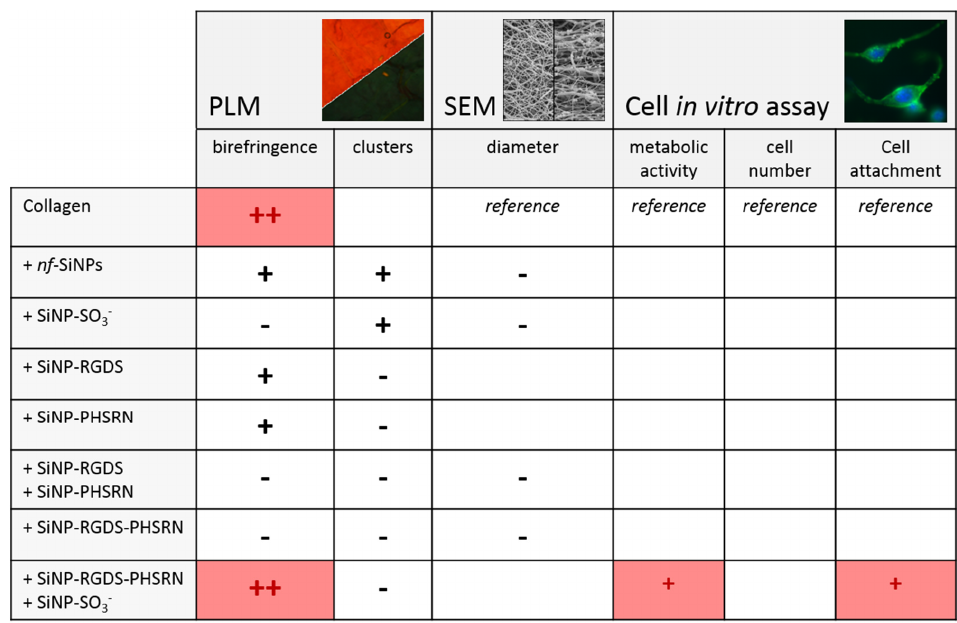
Figure 9. Structural features revealed by PLM and SEM and biological performances from cell in vitro assays for the eight bionanocomposites investigated in this study. The boxes left empty correspond to non-significant results compared to pure collagen films.